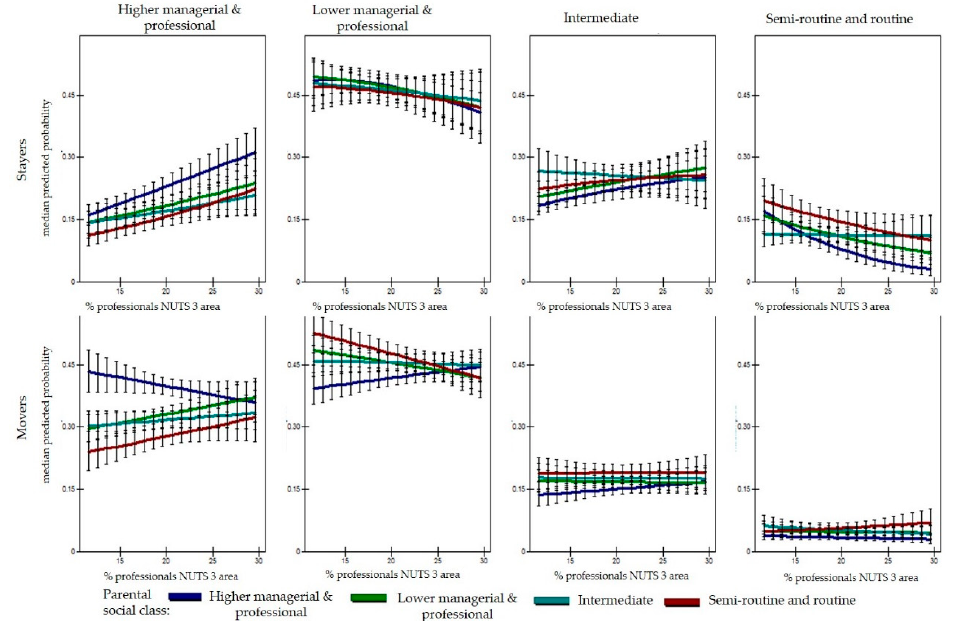
Figure 3. Graduates’ social class by social class of origin, by percentages of professionals in the employment area (NUTS 3) and by geographic mobility. Predicted median probability from a three-way interaction model.